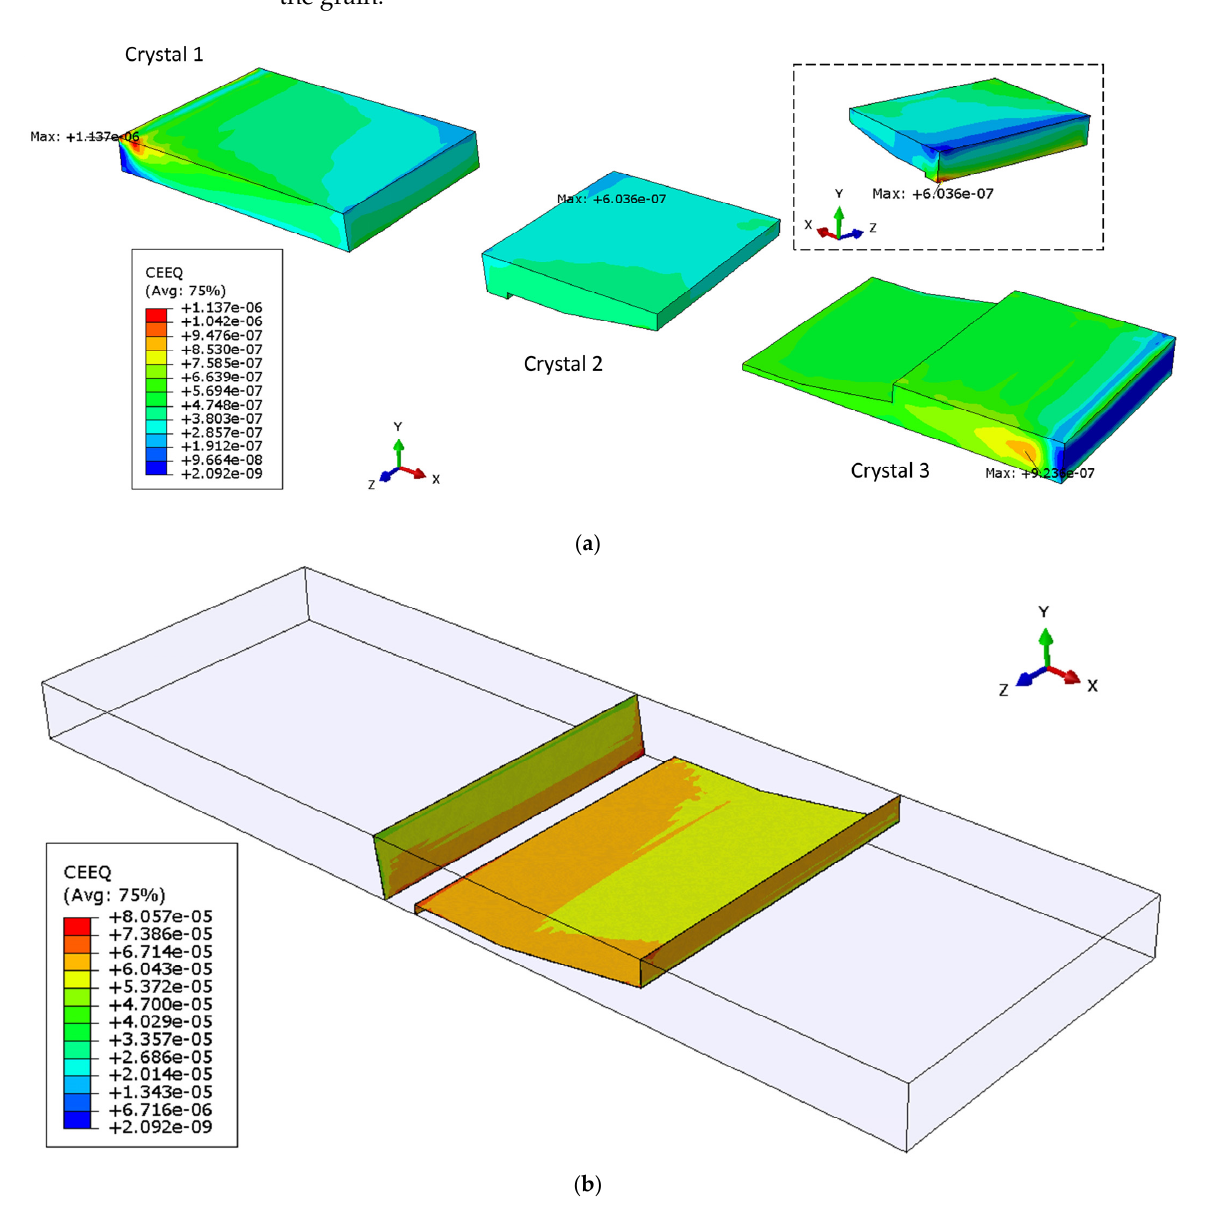
Figure 10. Equivalent creep strain contour of Sample 2 in: ( a ) each crystal, ( b ) grain boundary region. Within each joint, the concentration of creep stain varies considerably from crystal to crystal, which can be attributed to its own grain orientation, the misorientation with adjacent grains, the behavior of grain boundaries and the consequent complex stress distribution, etc. This strain heterogeneity is to some extent consistent with that observed in tested failed samples: the solder joint may crack along the interfacial layer connected to other structures/materials, or through the interior of the bump. In addition, internal cracks can be either transgranular, i.e., across grains, or intergranular, i.e., decohesion or sliding along grain